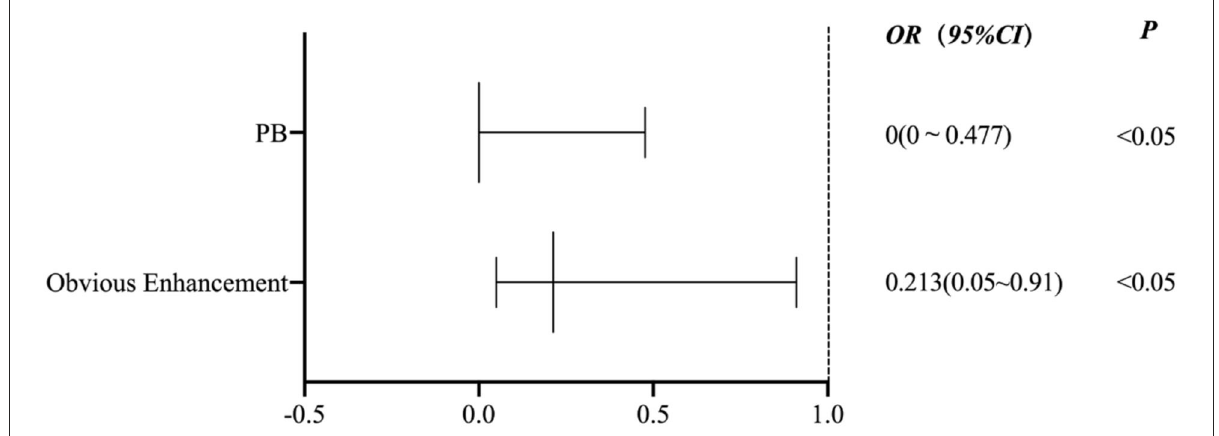
FIGURE5 A binary logistic regression analysis results for the parameters associated with the P group compared with the other